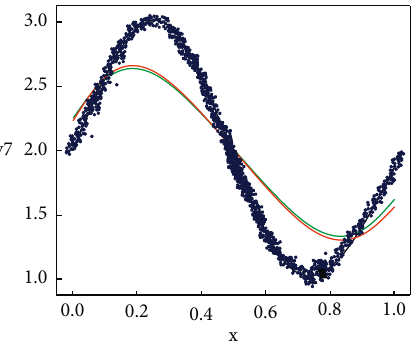
Figure 4: Finite population formed by trigonometric function